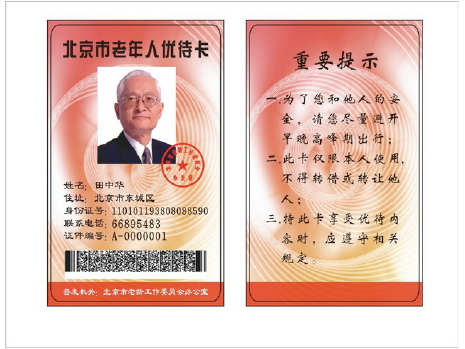
[Figure 1] ID card for the aged (aging certificate)